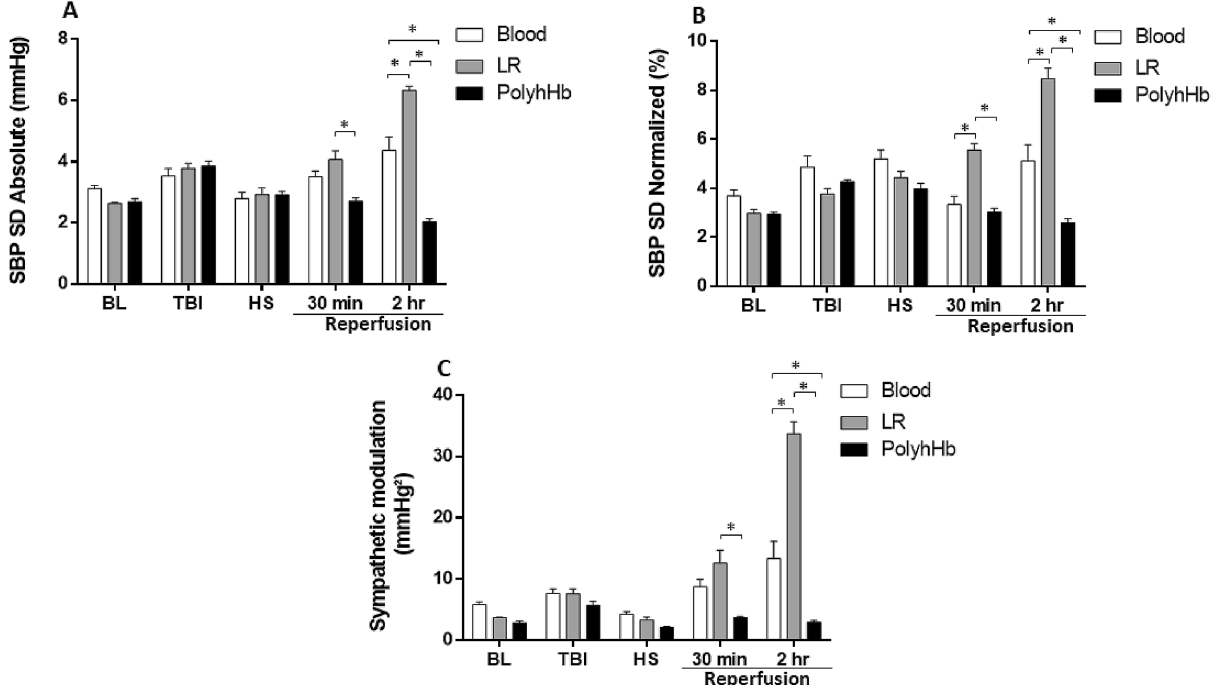
Figure 2. Analysis of systolic blood pressure variability during the polytrauma protocol. ( A ) Systolic blood pressure (SBP) standard deviation (SD) absolute; ( B ) SBP SD normalized; ( C ) sympathetic modulation. At BL (baseline); TBI (post traumatic brain injury); HS (hemorrhagic shock); 30 min into resuscitation; 2 h into resuscitation. LR Lactated Ringer’s solution. *p < 0.05. N =